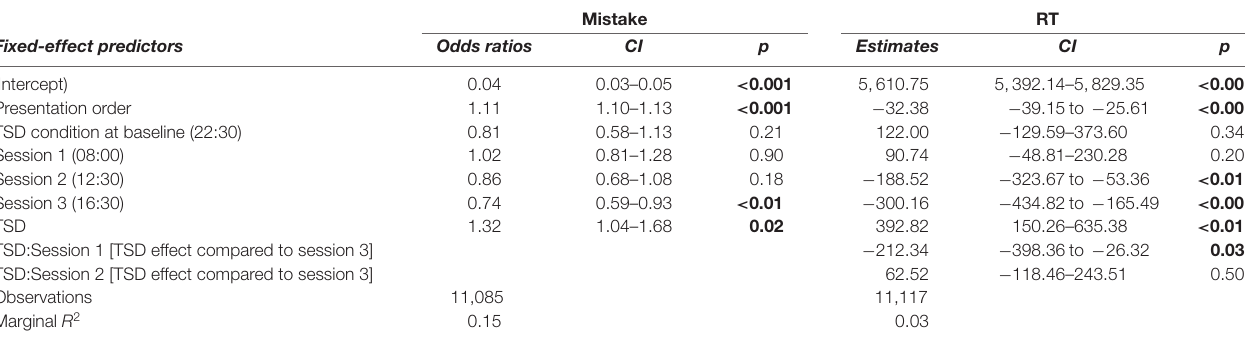
TABLE 2 | Arithmetic ability test performance predictions (odds ratios for making a mistake, and response times) based on sleep condition and time-of-day in the final mixed-effects model.